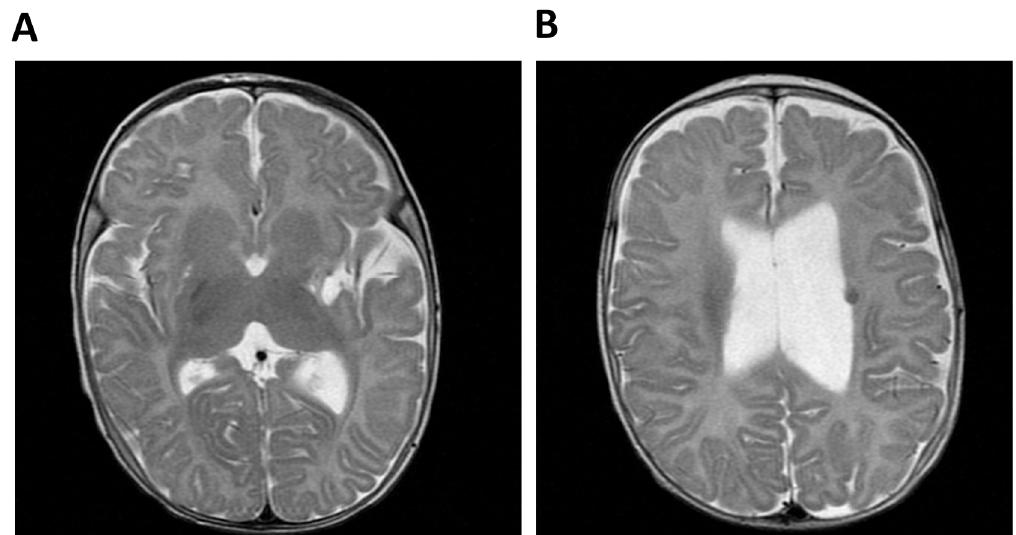
Figure 1. Cerebral MRI of Patient 1 (P1, index case). ( A ) Malacic area located at the lentiform nucleus and external left capsule and dilatation of the subaracnoid spaces of the insula and ( B ) Dilatation of the left lateral ventricle and T2-weighted hypointense lesion compatible with hemoglobin degradation.